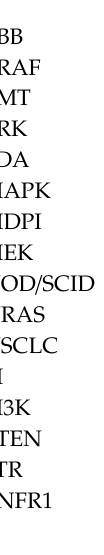
Supplementary Figure S1: Cell survival curves with indicated IC50 concentrations of cells grown as monolayers after treatment with buparlisib, trametinib or combination. Supplementary Figure S2: Protein expression of cell lysates after in vitro treatment with 10 µ M buparlisib, 10 µ M trametinib or combination (5 µ M + 5 µ M). Supplementary Figure S3: In vitro colony formation of H2 cells pre-treated with buparlisib and trametinib. Supplementary Figure S4: Migration of brain metastatic melanoma cells during and after pre-treatment with 10 µ M buparlisib, 10 µ M trametinib or combination (5 µ M + 5 µ M). Supplementary Figure S5: Cell migration towards a chemoattractant. Supplementary Figure S6: Morphology of human melanoma brain metastatic cell lines after treatment with 10 µ M buparlisib, 10 µ M trametinib or combination (5 µ M + 5 µ